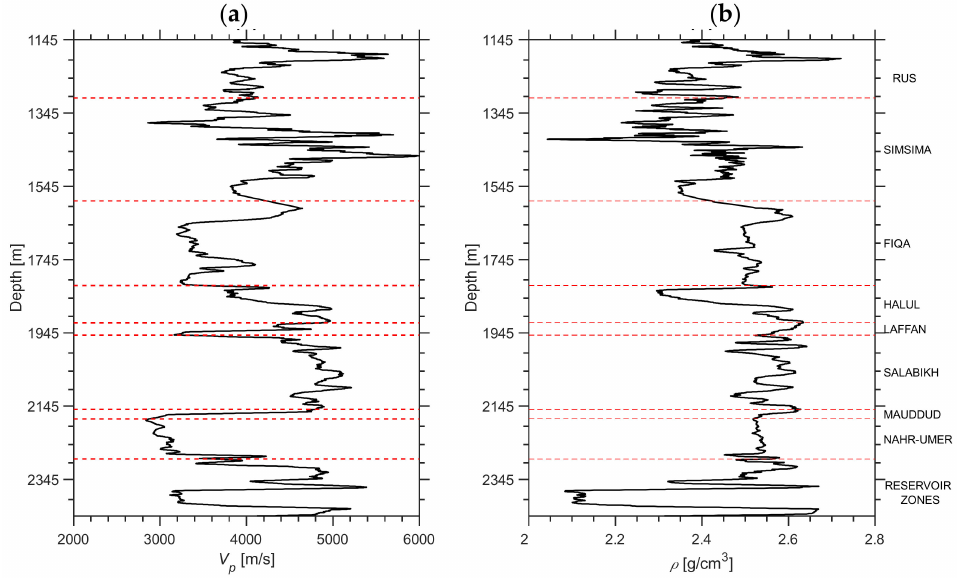
Figure 4. ( a ) Sonic and ( b ) density logs acquired in the 3D VSP well. The dashed horizontal lines and the text labels indicate the tops and names of the various geological formations